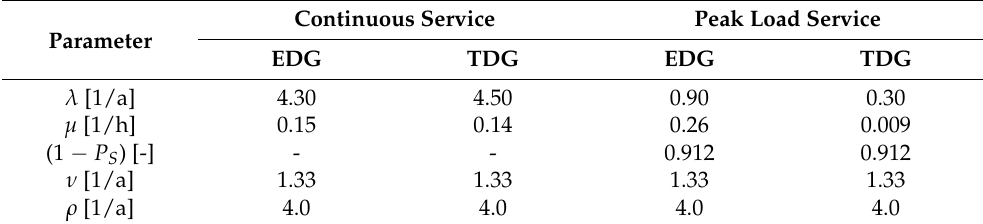
Table 2. Reliability parameters of EDG and TDG [64].